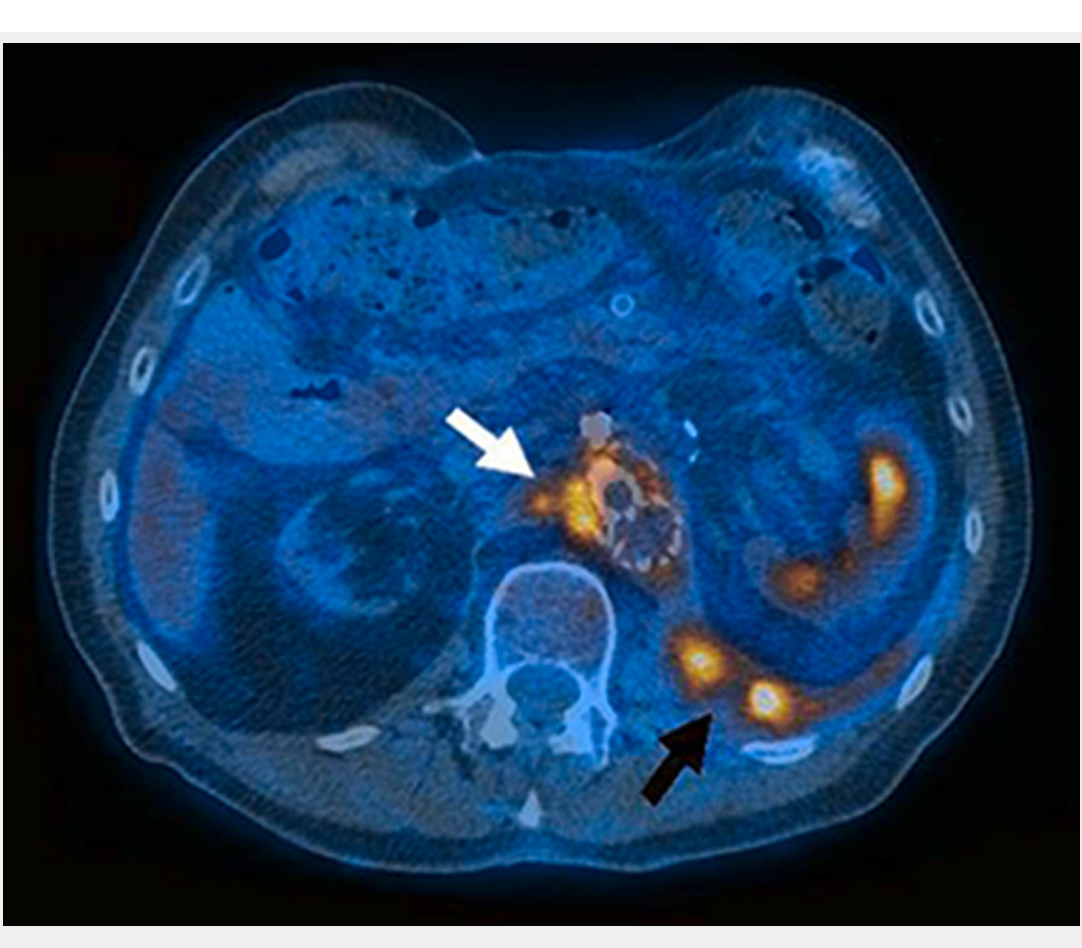
Figure 1 Distinct, focal metabolic activity (SUV 11.8) adjacent to the Y- and renovisceral grafts (white arrow) with a spatial extension to an abscess in the left psoas region (black arrow). ■■ imaging